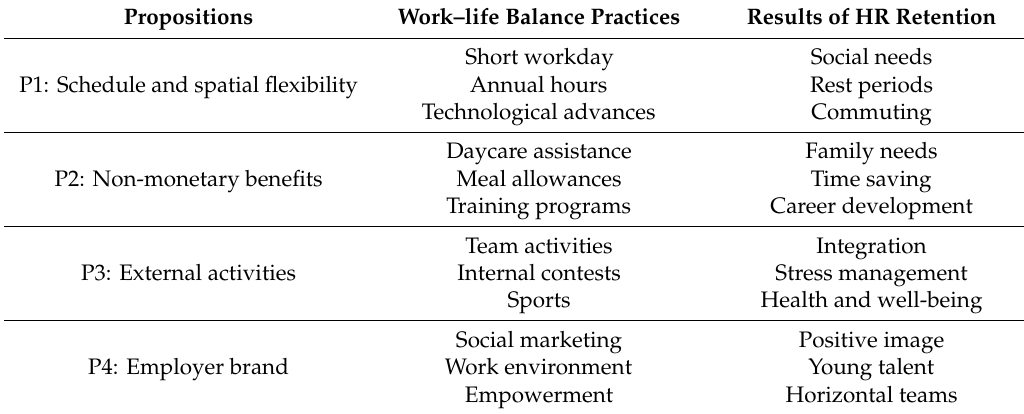
Table 2. Propositions, practices, and results regarding work–life balance management and their implications in the retention of valuable